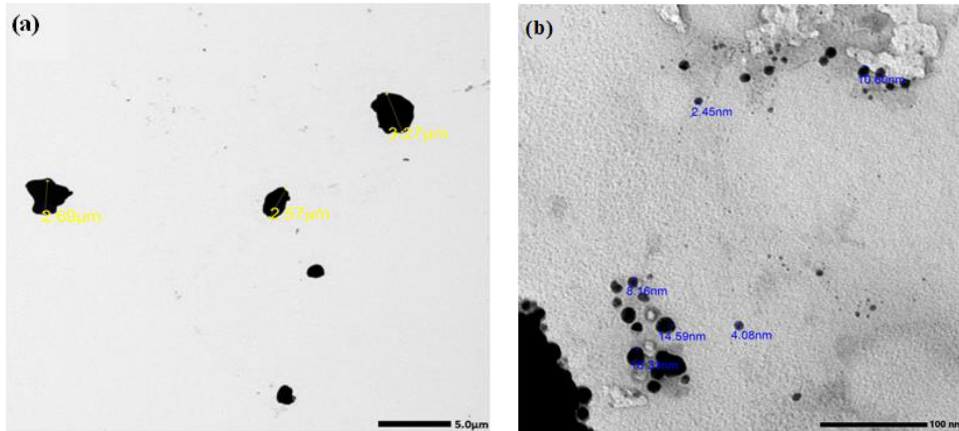
Figure 1. TEM images of ( a ) Bi 2 O 3 microparticles and ( b ) Bi 2 O 3 nanoparticles.